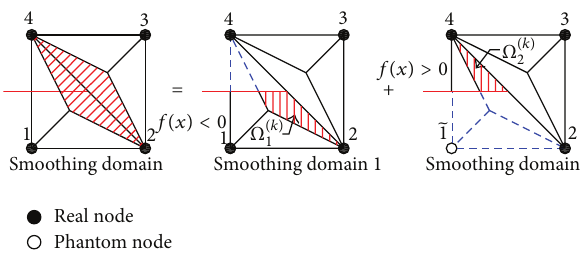
Figure 5: The decomposition of a cracked smoothing domain containing crack tip into two superimposed smoothing